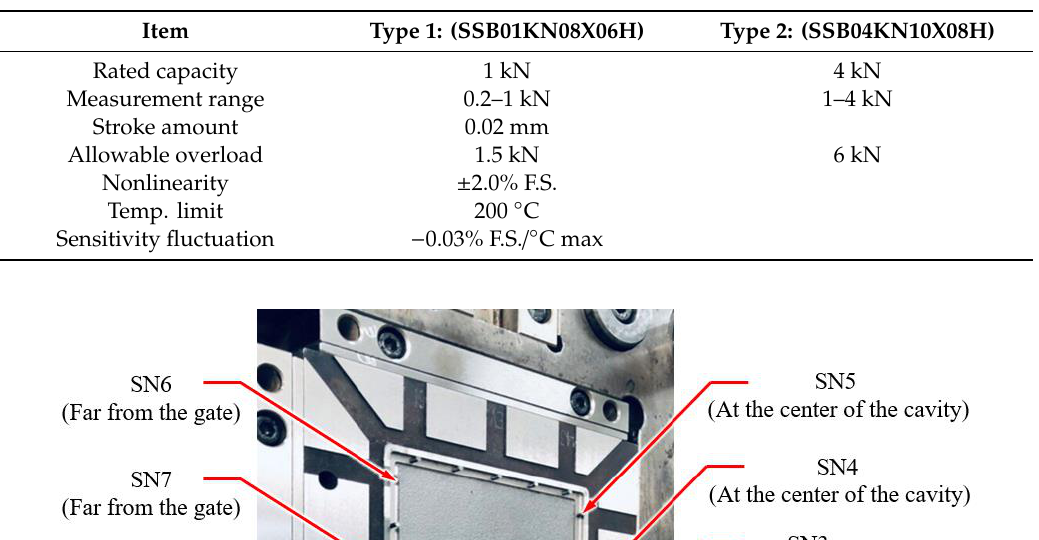
Figure 8. Layout of the cooling channel in the IC tray mold.